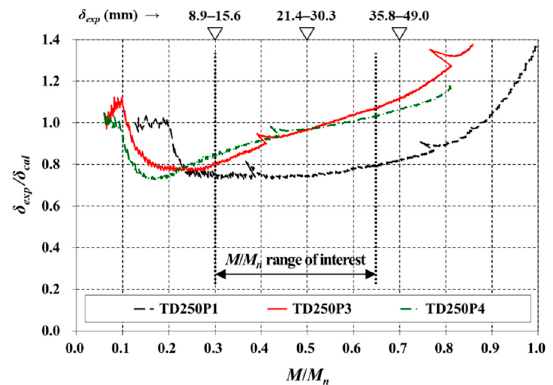
Figure 9. Comparison of immediate deflection (of other TD slabs with a variable of ρ ).